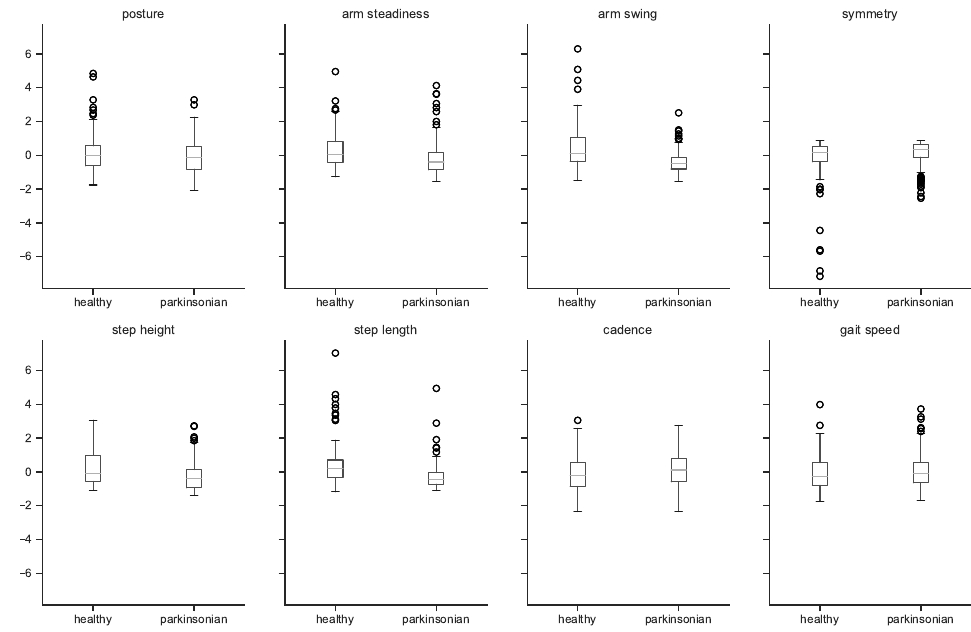
Figure A1. Features analysis by class (side view).